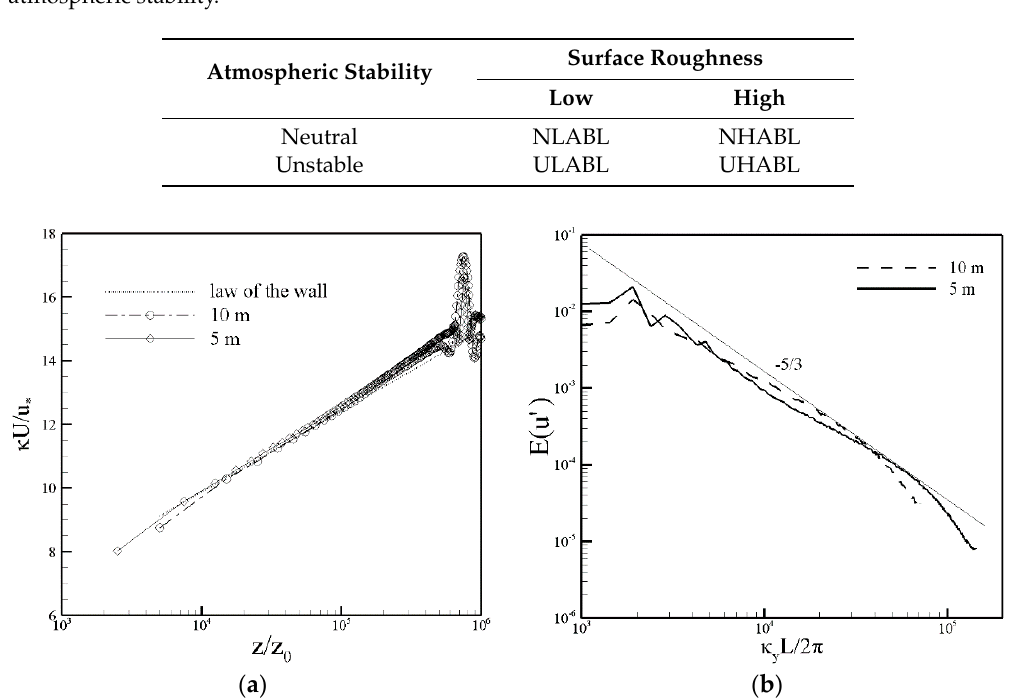
Table 1. Matrix of atmospheric boundary layer (ABL) test cases depending on surface roughness and atmospheric stability.